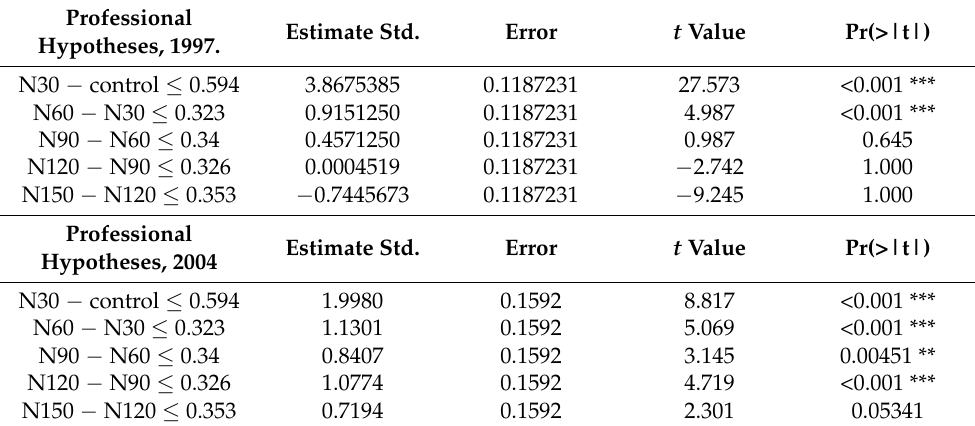
Table 5. Result of the simultaneous tests for general linear